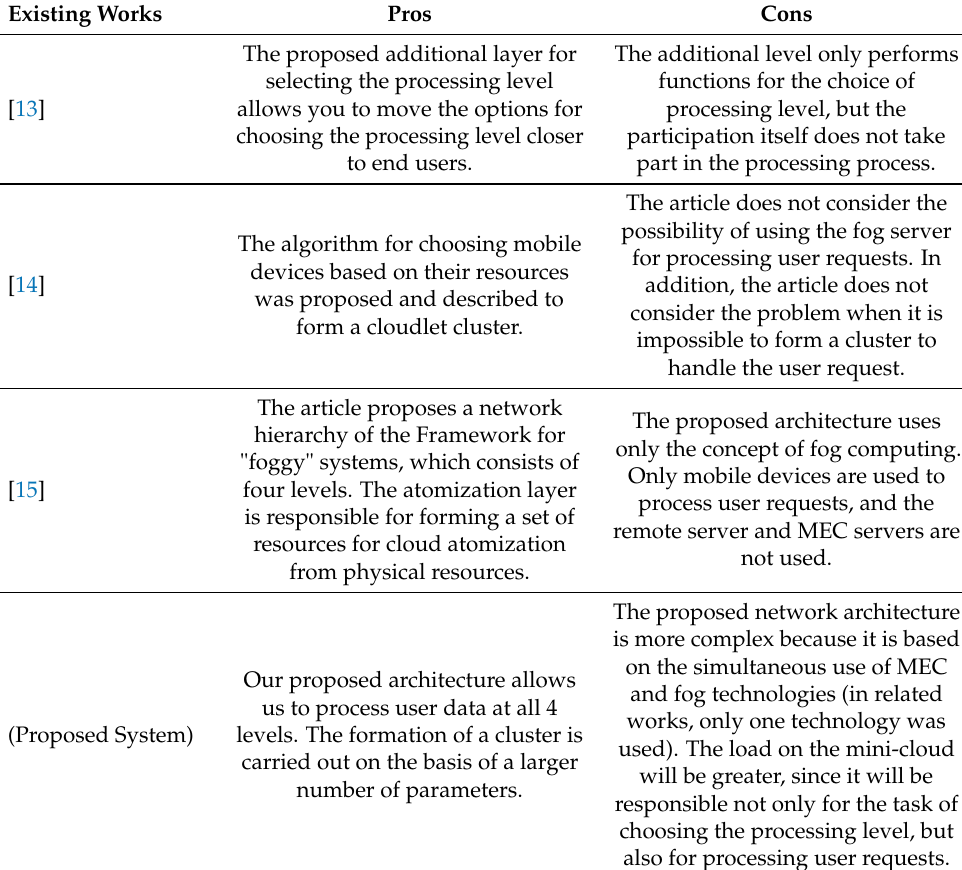
Table 2. Comparison systems from related works with our proposed